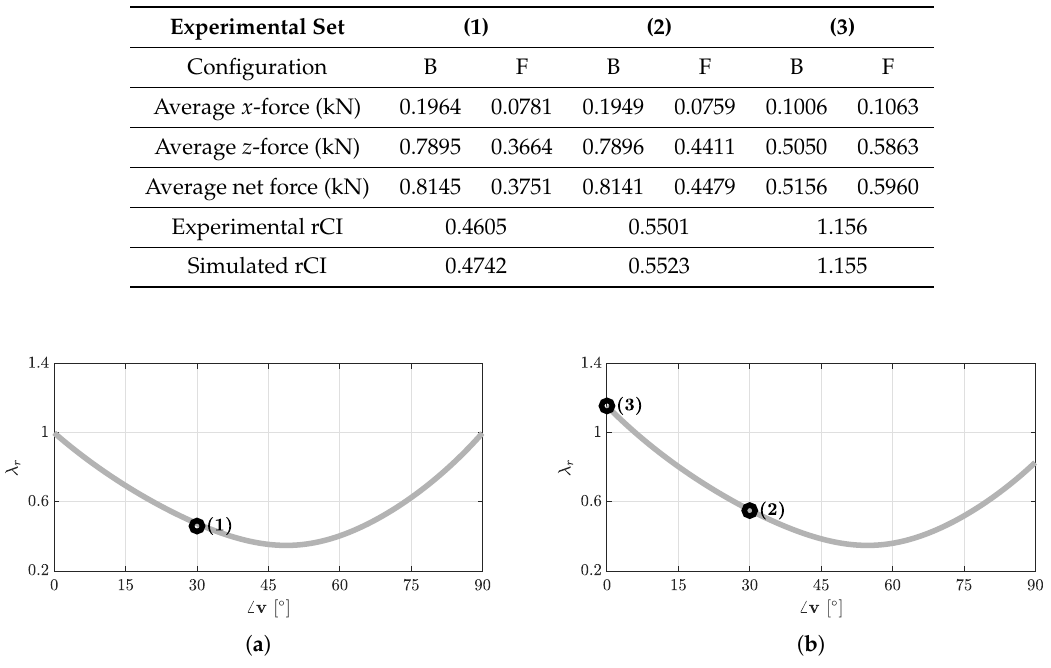
Figure 15. Impact forces for backward/forward flexion: ( a ) l n = 0.75, θ = 0 ◦ , and ∠ v = ∼ 30 ◦ , ( b ) l n = 0.75, θ = 8 ◦ , and ∠ v = ∼ 30 ◦ , ( c ) l n = 0.75, θ = 8 ◦ , and ∠ v = ∼ 0 ◦ . Table 2. Impact forces and rCIs for backward (B)/forward (F) flexion.